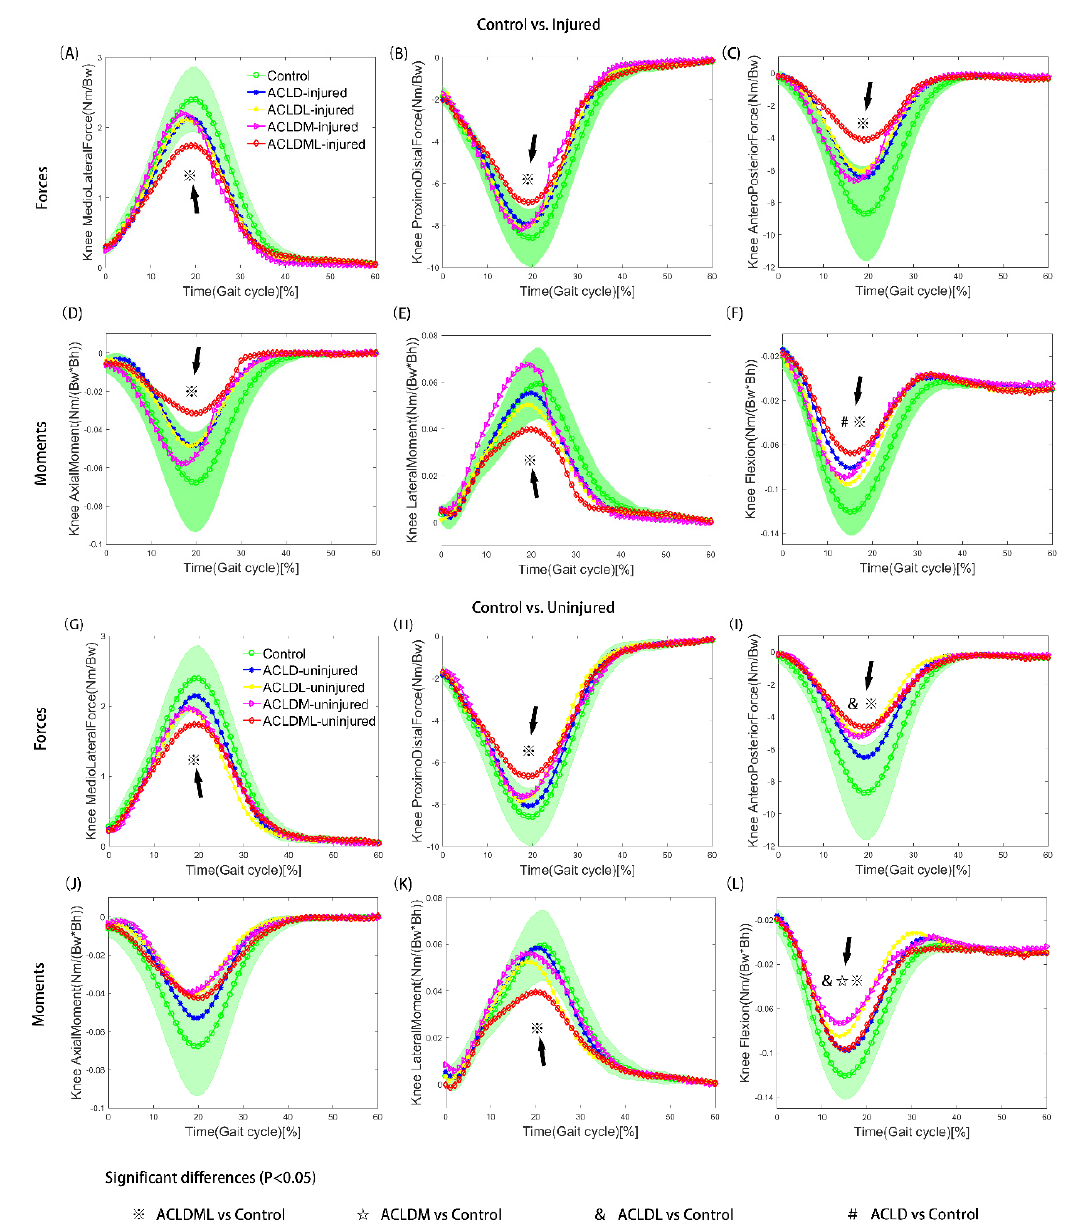
Figure 2. Tibiofemoral joint knee contact forces ( A − C , G − I ) and moments ( D − F , J − L ) of control and patient (ACLD, ACLDL, ACLDM and ACLDML) groups. Comparisons were conducted between control and injured limbs ( A − F ) as well as between control and uninjured limbs ( G − L ). Segments with significant statistical differences between every two groups were marked with symbols. The green shaded area represents the means ± standard deviation of the control group. ACLD, anterior cruciate ligament deficiency; ACLDL, ACLD combined with lateral meniscal injury; ACLDM, ACLD combined with medial meniscal injury; ACLDML, ACLD combined with lateral and medial meniscal injury. Bw: body weight; Bh: body height.